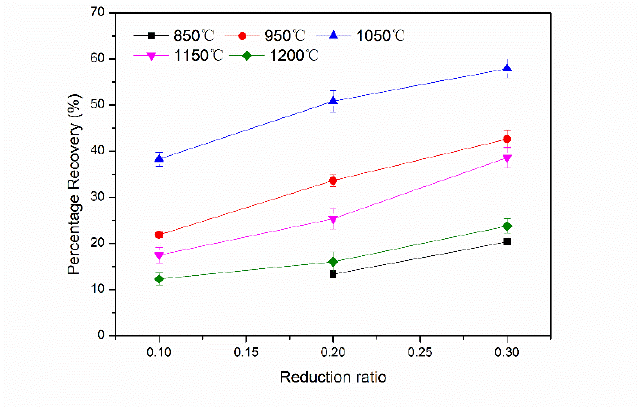
Figure 11. The percentage recovery of room-temperature Charpy-absorbed energy under various healing conditions.